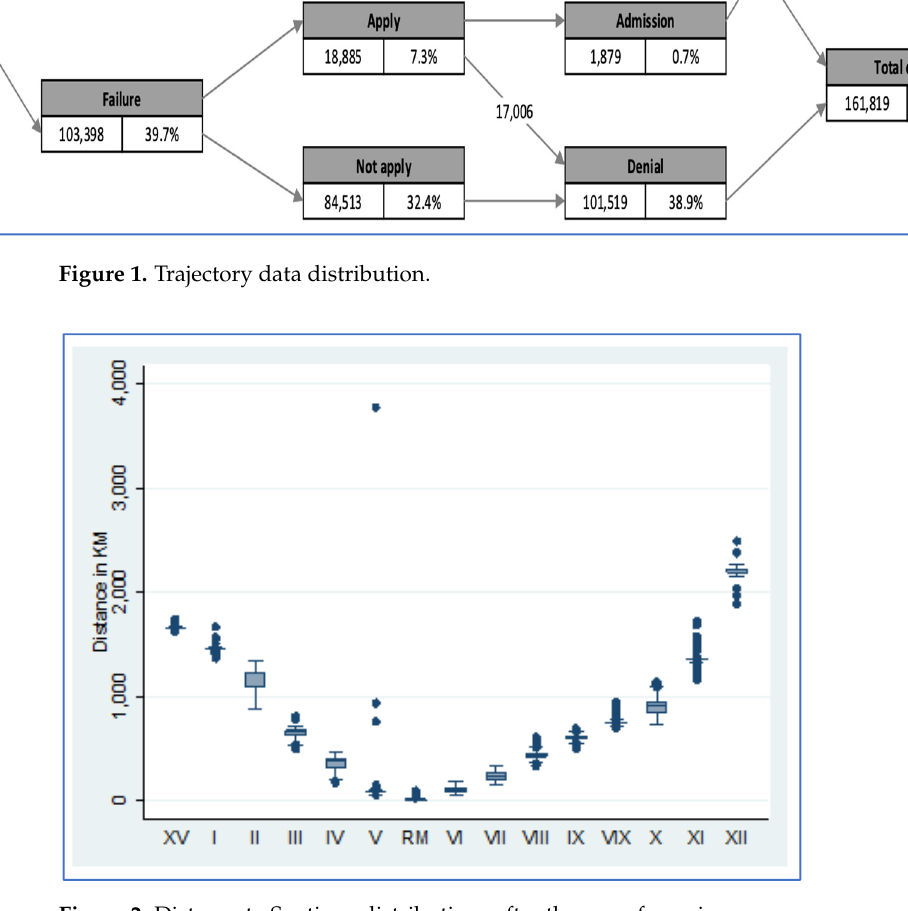
Figure 2. Distance to Santiago distributions after the georeferencing process.